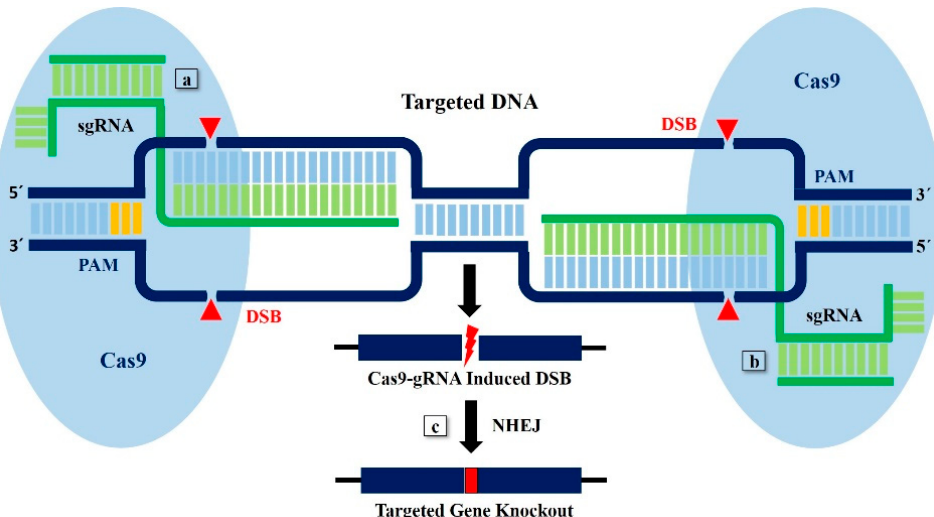
Figure 2. The specificity and wide adaptability of the CRISPR-Cas9 system offer huge potential for GroEL gene knockout. ( a , b ) At its simplest, the CRISPR-Cas9 system consists of the chimeric gRNA, which guides the Cas9 endonuclease to the target site. The target site of the GroEL gene is comprised of 20-bp of homology with the gRNA and a protospacer adjacent motif (PAM) sequence. Gene knockout is based on Cas9 endonuclease activity. A pair of Cas9 cleaves the target DNA and creates double-strand breaks (DSBs) at two di ff erent sites, which results in excision of genomic DNA fragments of the GroEL gene. ( c ) An imprecise non-homologous end joining (NHEJ) mediated repair will join the remaining DNA fragments.